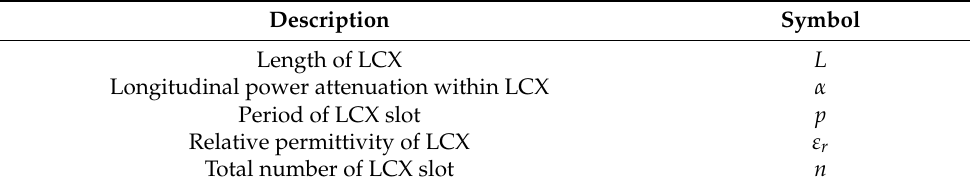
Table 2. Parameters for LCX.